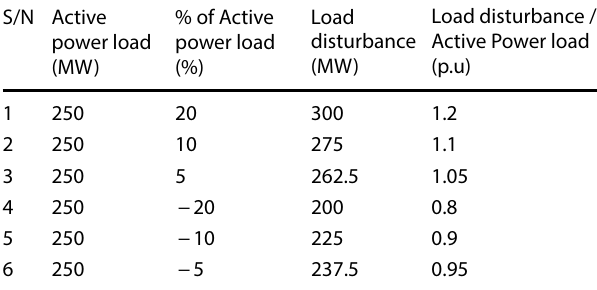
Table 1 Load Disturbances in per-unit introduced in testing sys- tems S/N Active power load